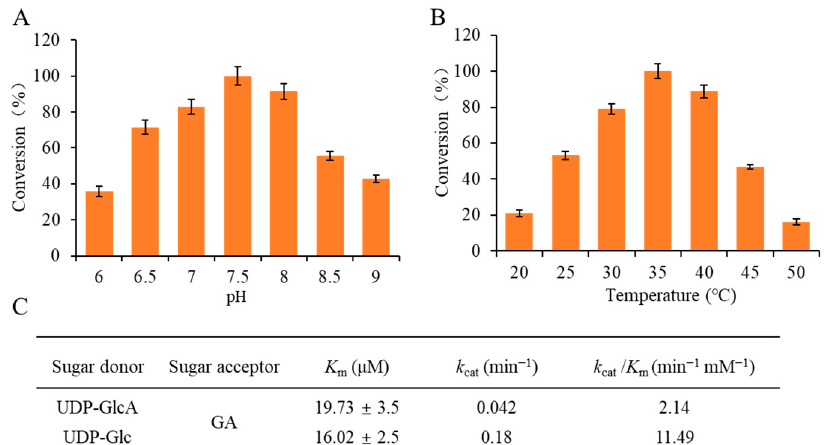
Figure 2. HPLC-MS analysis of the glycosylated products of GA and GAMG. ( A ) HPLC chromatograms of GAMG standards (a), UGT73F15-catalyzed reaction using GA and UDP-GlcA as substrates (b), UGT73F15-catalyzed reaction using GA and UDP-Glc as substrates (c), and UGT73F15-catalyzed reaction using GAMG and UDP-Glc as substrates (d). ( B ) MS spectra for products 1–4.